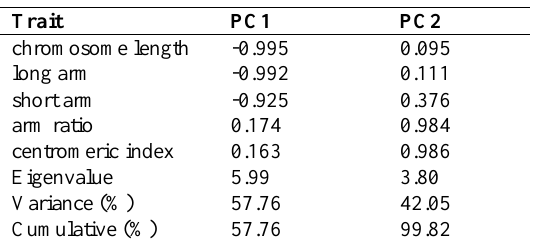
Table 4. Eigenvalues and cumulative variance for two principal components for six C. officinalis